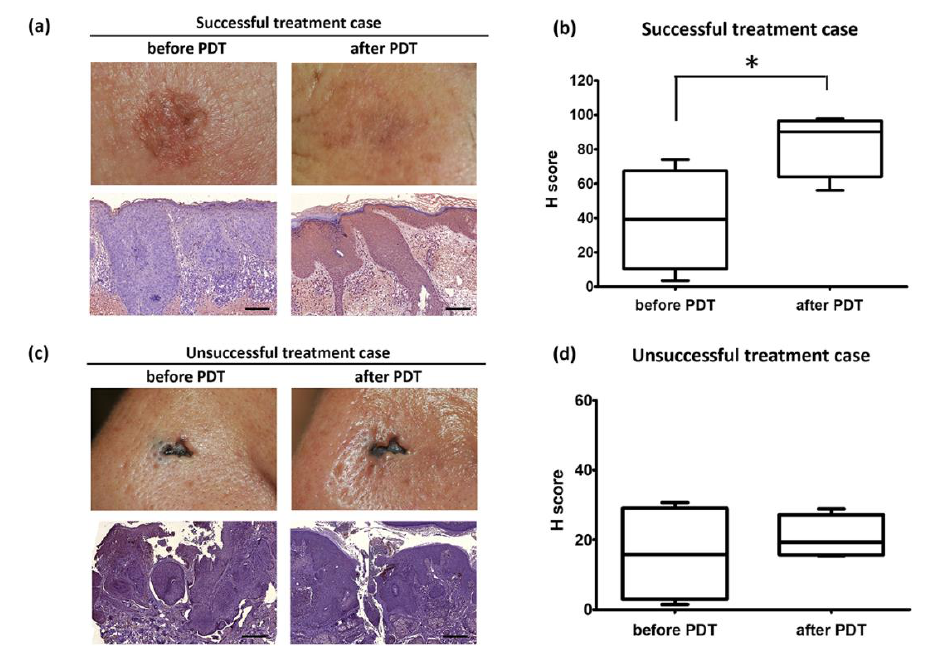
Figure 1. Comparison of erythroid di ff erentiation regulator 1 (ERDR1) expression following photodynamic therapy (PDT) in successful and unsuccessful treatments. ( a ) Images of lesions of actinic keratosis (AK) patients before and after PDT (top panels) and immunohistochemical staining of ERDR1 in skin tissue samples (lower panels). Scale bar = 10 µ m. ( b ) ERDR1 expression of four patients with successful PDT treatment quantified by digital image analysis, and an H-score (Histoscore) was calculated. To quantify the intensity of the ERDR1 expression, digital images of ERDR1-immunostained tissues were obtained using a panoramic scan slide scanner (3D HISTECH, Budapest, Hungary), and analyzed using the HistoQuant software (3D HISTECH) with the DensitoQuant algorithm (3D HISTECH). The DensitoQuant algorithm shows five di ff erent color images assigned according to staining intensity (red, orange, yellow, blue, and white, indicating strongly positive pixels, moderately positive pixels, weakly positive pixels, negative pixels, and the hematoxylin background, respectively). The algorithm automatically calculates the ratio of positive to total pixels by the formula [1 × (% of weakly positive pixels) + 2 × (% of moderately positive pixels) + 3 × (% of strongly positive pixels)] to provide an H-score. An unpaired t-test was performed to analyze the intensity of the ERDR1 expression between the two groups before and after PDT. The results represent the mean ± standard error of the mean (SEM) and H-score from four di ff erent donors. *denotes statistically significant ( p < 0.05) changes from before PDT. ( c ) Images of lesions of BCC patients before and after PDT (top panels), and immunohistochemical staining of ERDR1 in skin tissue (bottom panels). Scale bar = 10 µ m. ( d ) The ERDR1 expression of four patients with unsuccessful PDT treatment was quantified. Data for H-scores are shown as mean ±